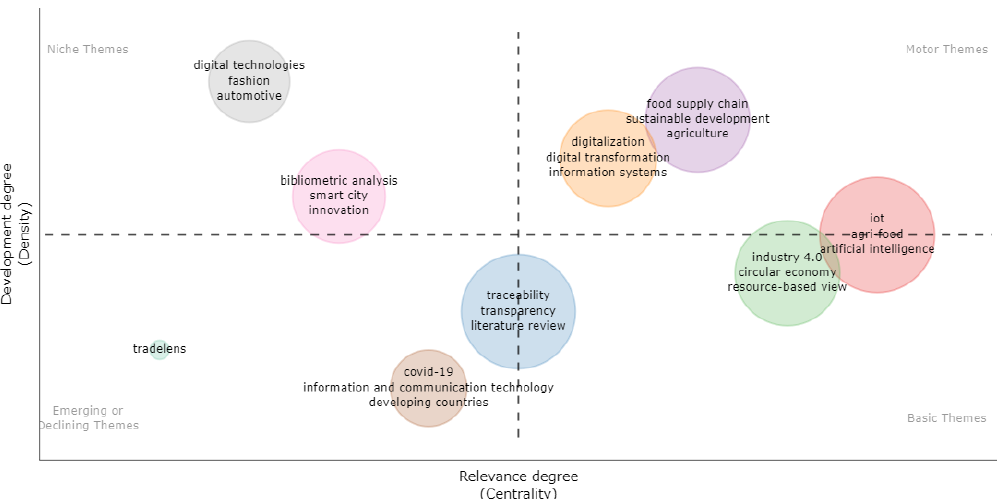
Figure 6. Thematic Map (2017–2020).